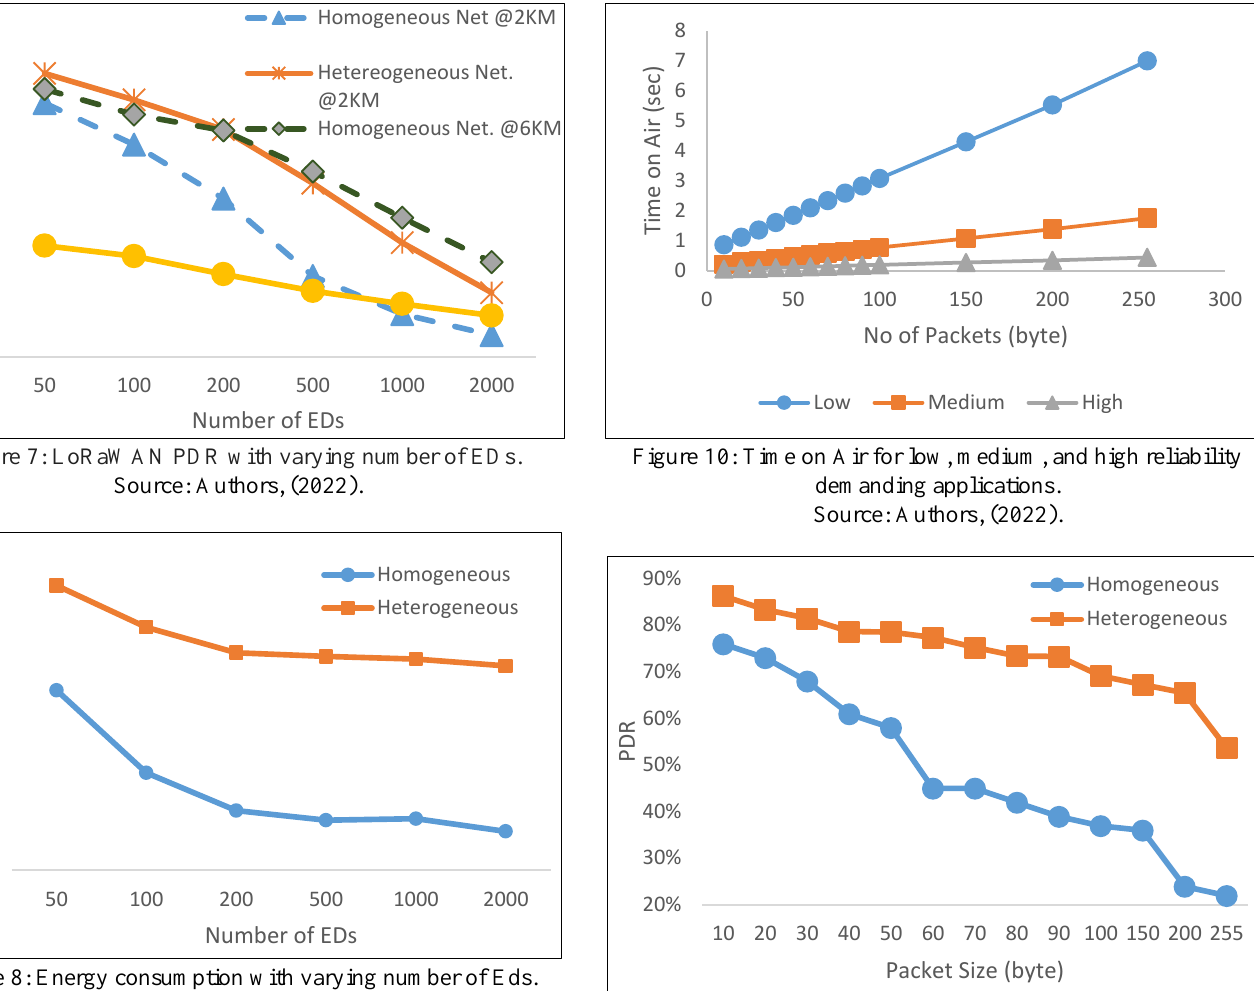
Figure 11: PDR with packet size.